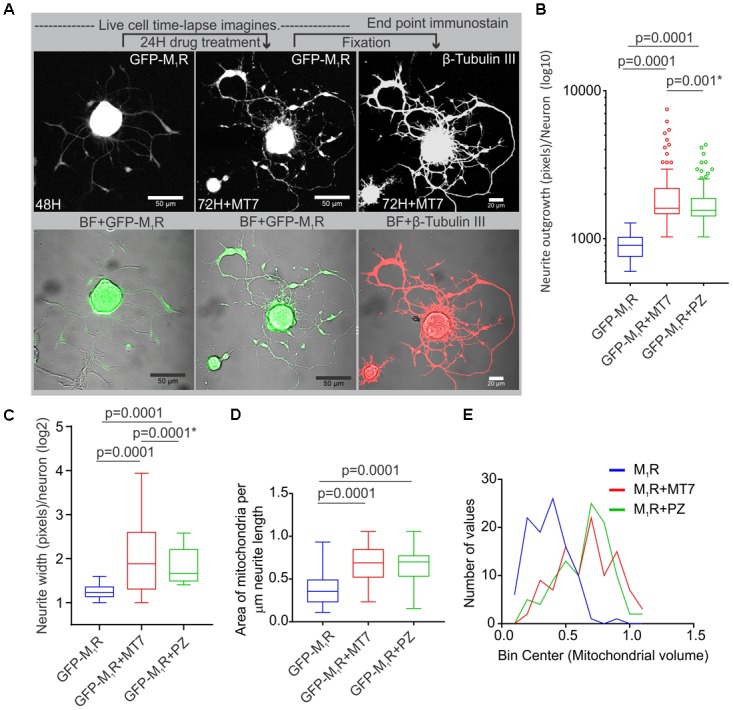
Restoration of cytoskeleton, mitochondrial abundance and neurite outgrowth by M1R antagonists MT7 and pirenzepine treatment. (A) Time-lapse live confocal images of GFP-M1R over-expression in sensory neurons showing MT7 induced re-localization of M1R from perikaryon to neurites. The overexpressed neurons were grown in defined media for 48 h and imaged (left panel). Neurons were then treated with 100 nM MT7 for 24 h and imaged (middle panel). Right panel: The same neuron depicted left was fixed and stained for β-tubulin III to show continuity of cytoskeleton. Scale bars: 50 μm. (B,C) Whiskers box (Tukey) showing total neurite outgrowth per neuron (B) and average neurite width per neuron (C). p-value calculated by one-way ANOVA, N = 224, 230 and 198 cells, respectively, for (A) and N = 1250, 1268, 1280, and 1306 cells, respectively, for (B). Asterisks indicate p-value calculated by unpaired t-test. (D) Whisker box plot showing amount of mitochondria in the M1R expressing neurons treated with 100 nM MT7 or 1 μM pirenzepine. N = 101, p-values were calculated by one-way ANOVA followed by Dunnett’s multiple comparisons tests. (E) Binning of the entire data set presented in (D).